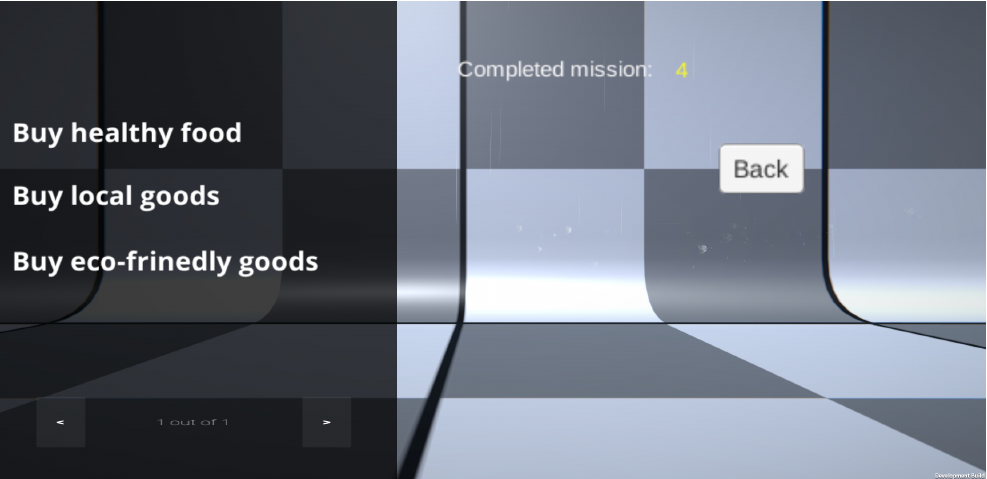
Figure 2. Mission interface. The left side shows the daily mission, and the upper right corner shows the number of mission